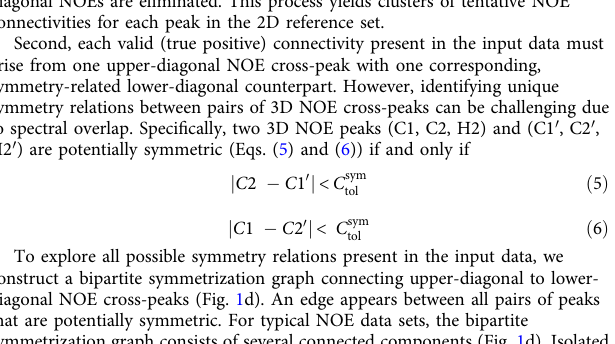
Table 2. Ile δ 1 methyl types were identi fi ed by their characteristic up fi eld chemical shifts. Leu and Val methyl types were identi fi ed using phase-sensitive 2D 1 H- 13 C HMQC experiments recorded on the ILV * -labeled sample 18 . Alanine methyl types were identi fi ed by comparing 2D 1 H- 13 C HMQC spectra of AILV and ILV proS samples, and by comparing Ala C β chemical shifts from HN(CA)CB experiments. Finally, stereospeci fi c Leu δ 2 and Val γ 2 methyl assignments were obtained by comparison of 2D 1 H- 13 C HMQC spectra of AILV- and ILV proS -labeled samples. All the data were recorded at a 1 H fi eld of 750 or 800 MHz at 25°C. The 3D SOFAST NOESY experiments were recorded at 800 MHz, 25 °C using a recycle delay of 0.2 s, and NOE mixing time of 50 ms and 300 ms. Typical data acquisition times were 1h for the 2D HMQC, 8 – 10h for the 50 ms, and 12 – 14h for the 200 ms 3D SOFAST NOESY-HMQC experiments. All spectra were acquired using Topspin 3 acquisition software from Bruker. The data were processed in NMRPipe 34 and analyzed in NMRFAM-SPARKY 35 and CcpNMR 36 programs. Stereospeci fi c isotopic labeling . A speci fi cally methyl-labeled acetolactate pre- cursor (2-[ 13 CH 3 ], 4-[ 2 H 3 ] acetolactate) was obtained through deprotection and 300 mg of ethyl 2-hydroxy-2-( 13 C)methyl-3-oxobutanoate was added to 24 mL of a 0.1M NaOD/D 2 O solution. After 30 min, the solution was adjusted to neutral